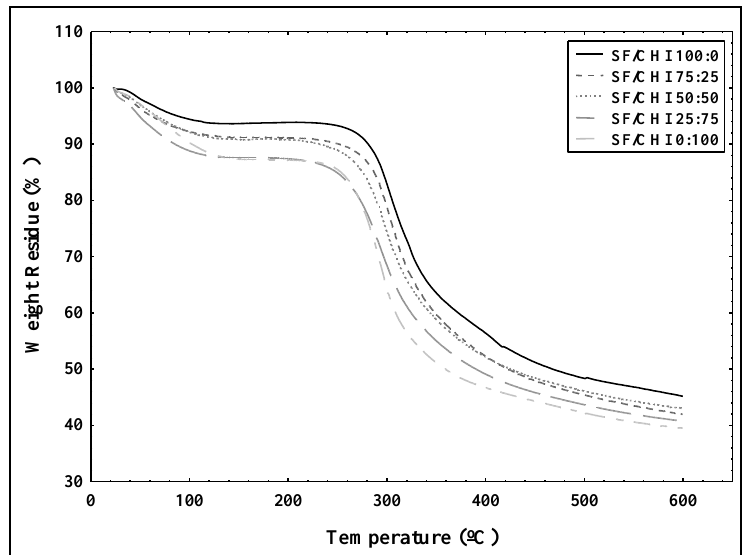
Figure 4. Thermogravimetric curves of SF/CHI blended films with the indicated SF:CHI